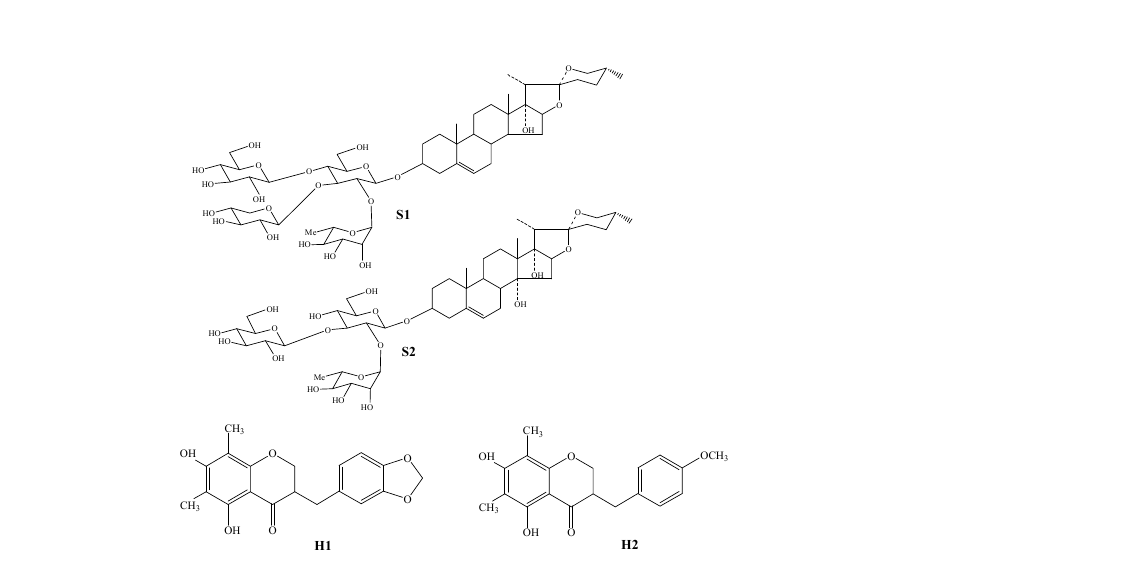
Figure 5. Chemical structures of four characteristic constituents in ZOJ: Cixi-ophiopogon B (S1), Cixi-ophiopogon C (S2), Methylophiopogonanone A (H1), and Methylophiopogonanone B (H2).